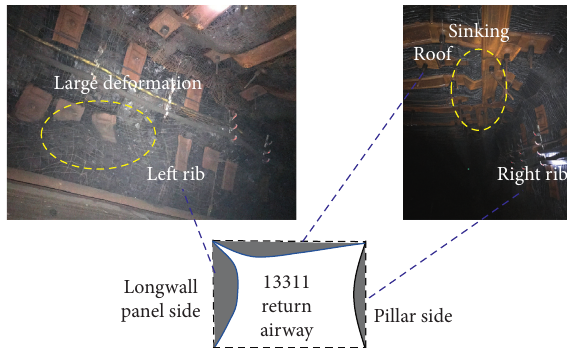
Figure 4: Field deformation of the 13311 return